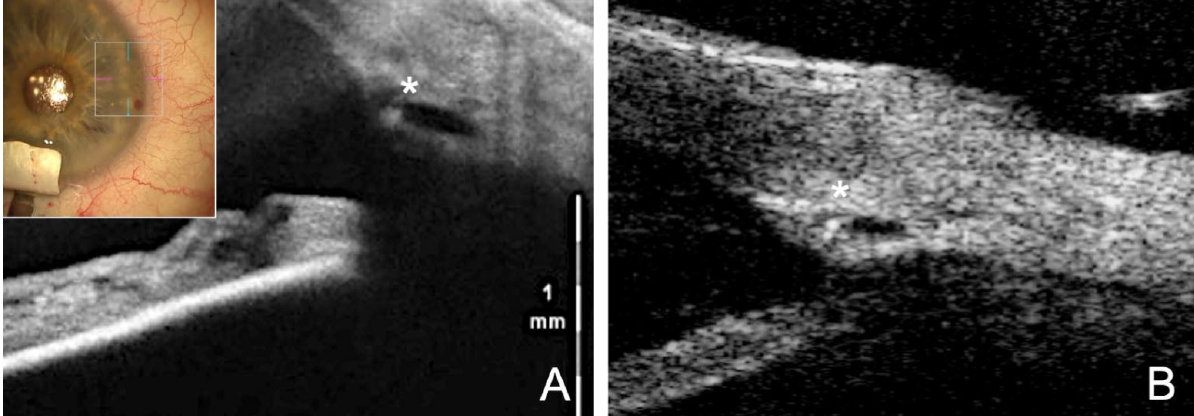
Figure 4. Visible effect of the tension suture stretching the SC. ( A ) Intraoperative visualization of the SC with intraoperative OCT. Asterisk marks the catheter tip within the lumen. ( B ) Postoperative UBM (50 MHz) clearly shows the dilated and stretched SC with knotted suture in the lumen (asterisk).